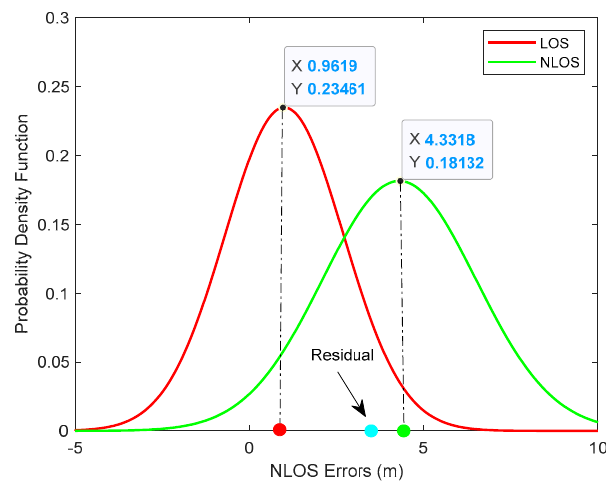
Figure 3. The mixture Gaussian fit result.